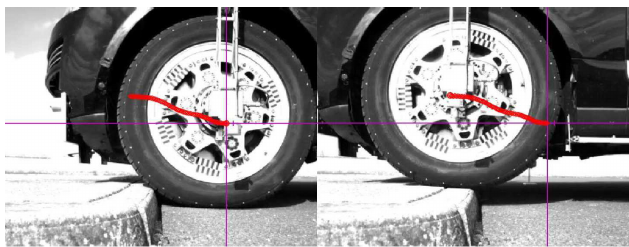
Fig. 9. Measured wheel centre trajectories of the front-left wheel of the vehicle going over the curb